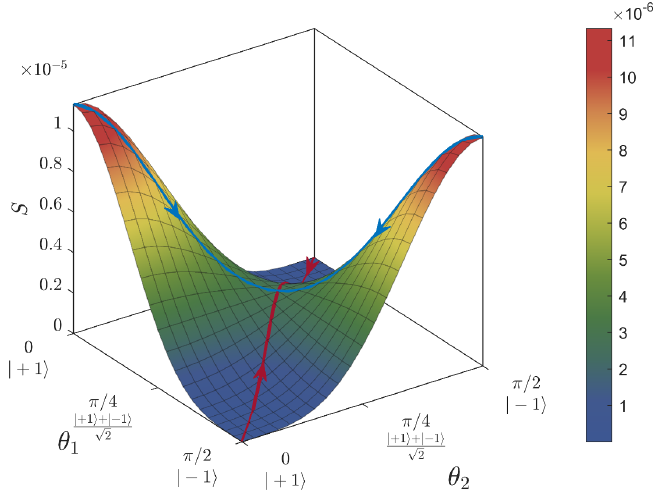
Figure 3 . The entanglement entropy of the outcome states vs θ 1 and θ 2 with the initial states ( cos θ 1 | + 1 i + sin θ 1 | − 1 i ) ⊗ ( cos θ 2 | + 1 i + sin θ 2 | − 1 i ) , m 1 = m 2 = m , G N m 2 = 10 − 5 , | b | m = 10 , p/m = 100 , C 1 , 2 = C 2 , 2 = 1 . 5 . This graph contains the configurations of squeezed states. The blue line shows when we squeeze both particles starting from parallel configurations ( | + 1 i ⊗ | + 1 i or | − 1 i ⊗ | − 1 i ) to the middle point, the entanglement entropy decreases. The red line shows when we squeeze both particles starting from anti-parallel configurations ( | + 1 i ⊗ | − 1 i or | − 1 i ⊗ | + 1 i ) to the middle point, the entanglement entropy